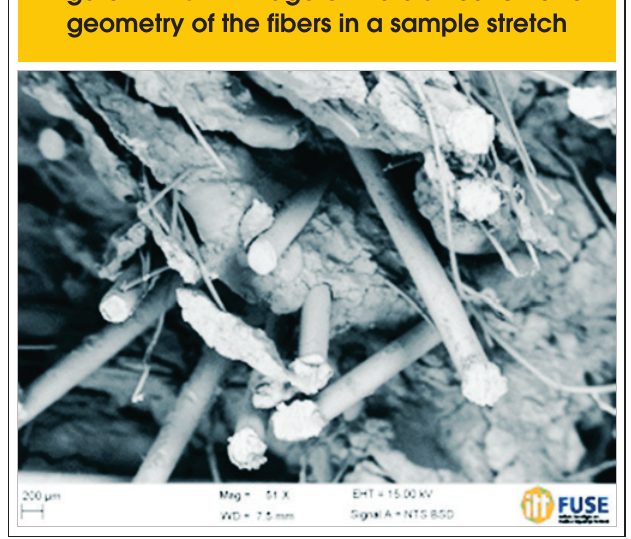
Figure 11 – SEM image of the distribution and geometry of the fibers in a sample stretch